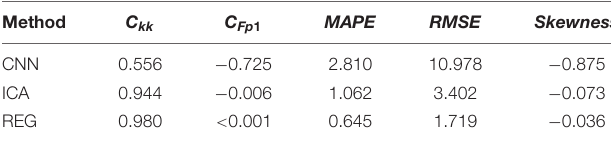
TABLE 6 | The averaged values of Ckk , C Fp 1 , MAPE , RMSE , and Skewness for the Oz